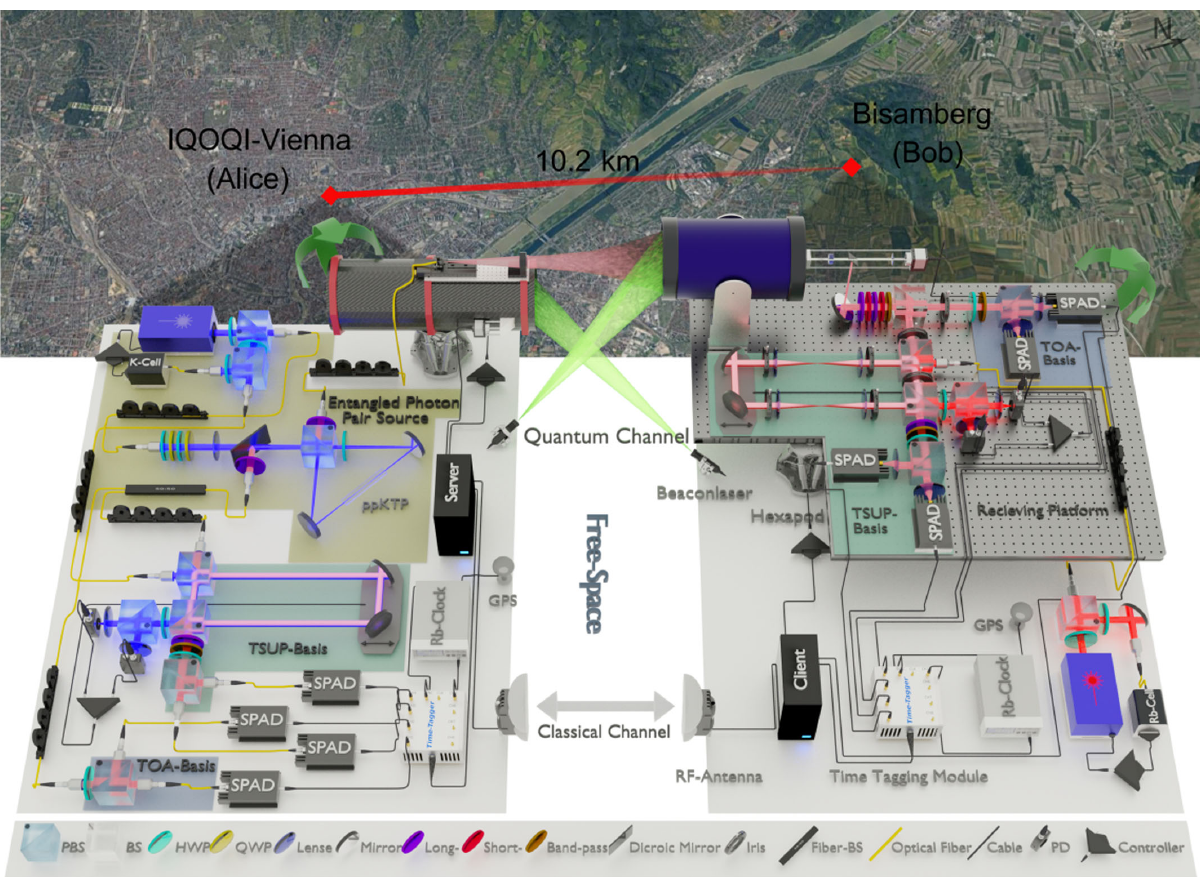
FIG. 1. Illustration of the high-dimensional quantum key distribution experiment. The free-space link is established between the sender at IQOQI Vienna (Alice) and the receiver at Bisamberg (Bob) in Lower Austria over a distance of 10.2 km. The hyperentangled photon source is pumped by a 39 K stabilized laser at 404.532 nm. The hyperentangled state is set by adjusting a combination of half- wave (HWP) and quarter-wave (QWP) plates. The hyperentangled photons produced at 808.9 nm by a ppKTP crystal are separated and guided to the receivers Alice and Bob who by the aid of a 50 ∶ 50 beam splitter (BS) randomly measure their photons in the time-of- arrival (TOA) and the temporal superposition (TSUP) basis. By using polarizing beam splitters (PBS) in the Mach-Zehnder- Interferometers (MZI) followed by a polarization measurement in the D/A basis, we achieve postselection-free Franson interference. While Alice analyzes her photons locally, Bob ’ s photons are transmitted over the free-space link to Bisamberg. The MZI is locked to the pump laser stabilized by a piezoactuator controlled by the interferometric intensity changes measured by two photodetectors (PD). The photon detection events are recorded by single-photon avalanche diodes (SPAD), time stamped by the time-tagging module, and streamed to the server. The photons received at Bob are guided to his detection modules where we use several irises as optical baffles and combinations of optical filters to reduce the influence of background radiation. Bob ’ s measurements are corresponding to Alice ’ s, with the difference of having two 4 f systems in the MZI to compensate for the atmospheric turbulence; Bob ’ s MZI is locked to a 87 Rb stabilized laser at 780.23